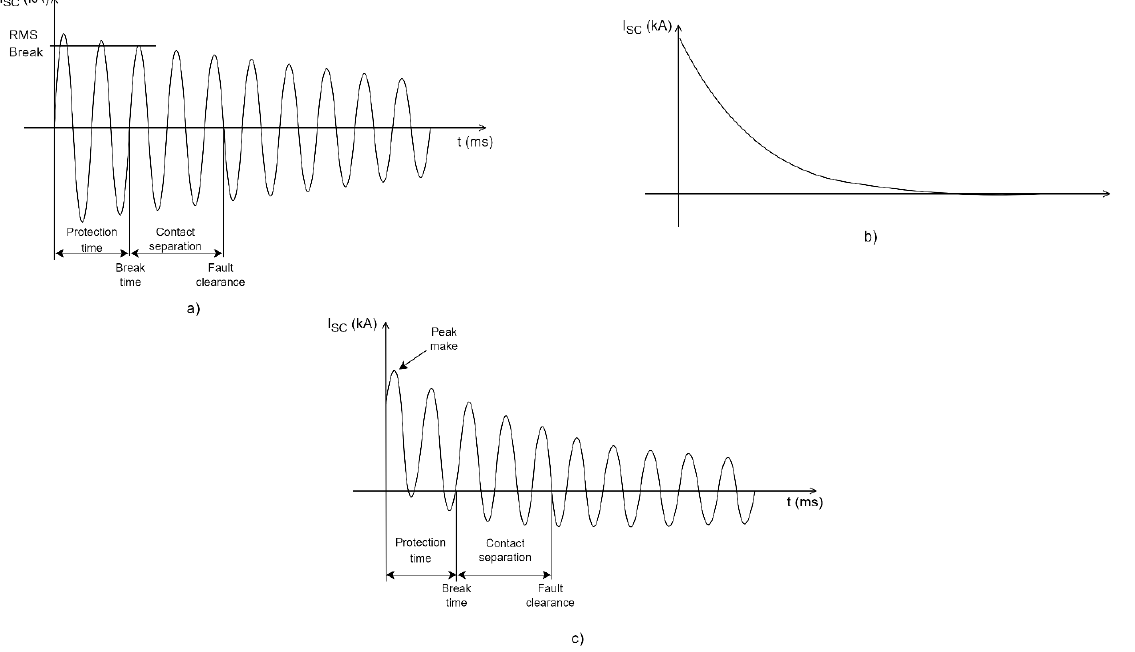
Figure 7. Oscillogram displaying a general waveform of a short-circuit current, with separate: ( a ) AC component, ( b ) DC offset component and ( c ) combined AC and DC components.